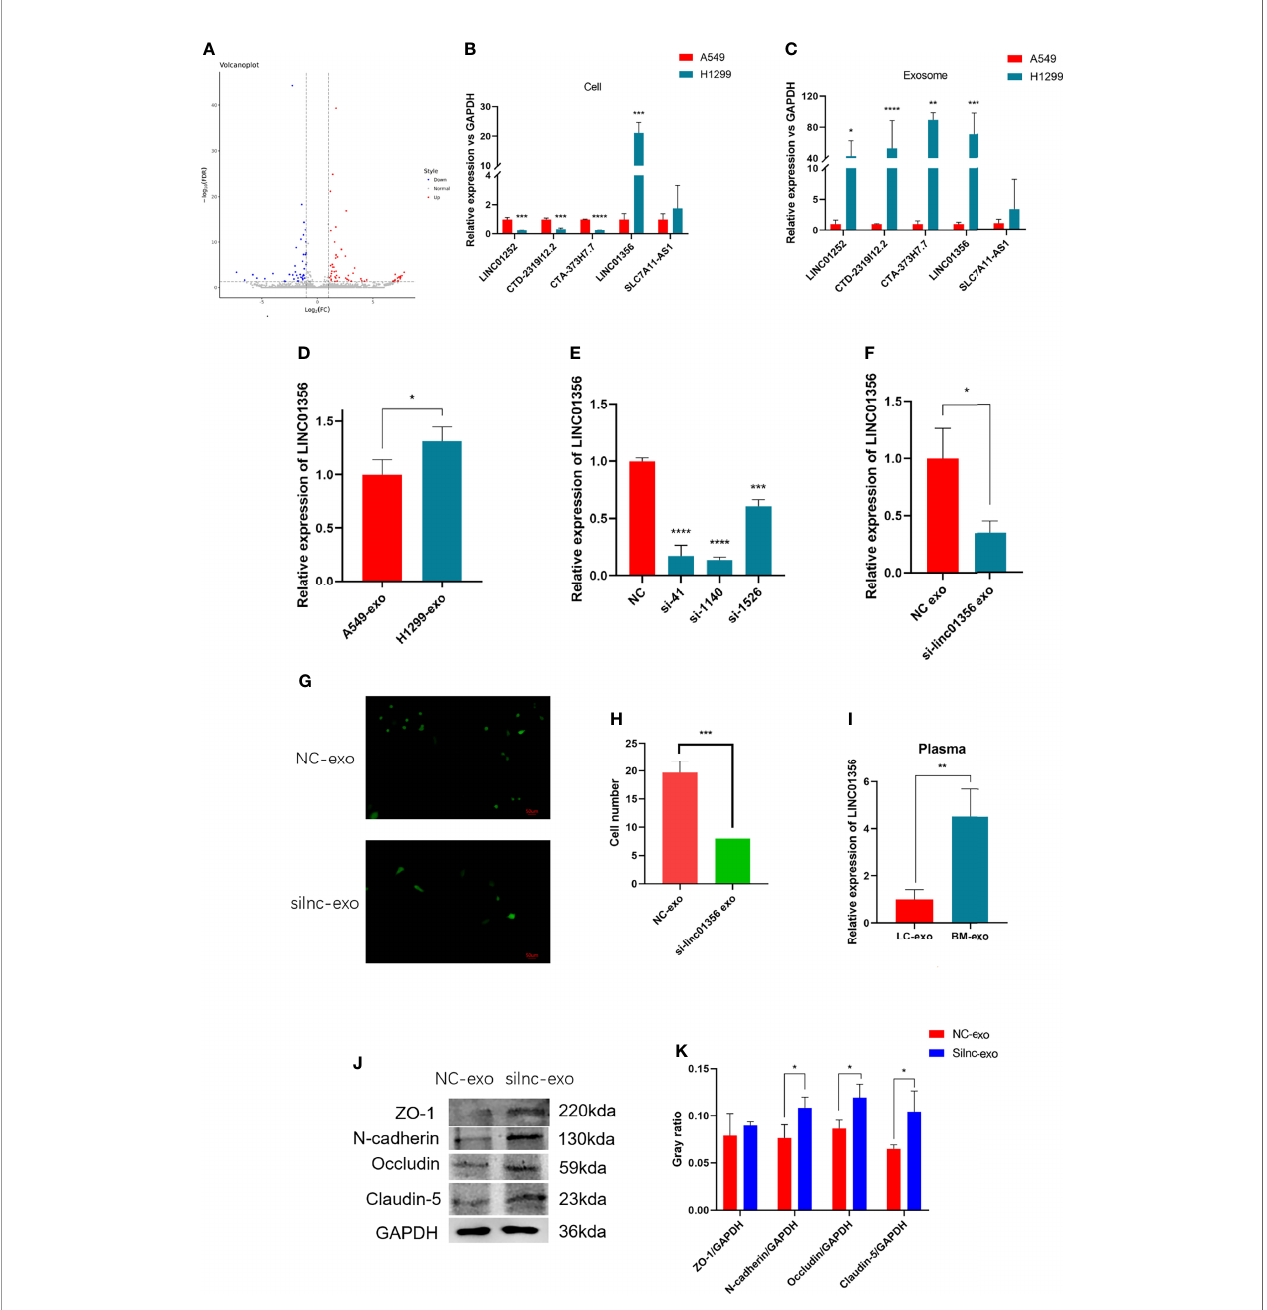
FIGURE 4 | Mechanism of exosomal LINC01356 in vitro BBB model remodeling and lung cancer brain metastasis. (A) Volcano plot of differentially expressed lncRNAs between brain metastatic and nonbrain metastatic lung cancer cells. Data were obtained from the GSE126548 database. (B) The top fi ve most highly differentially expressed lncRNAs were veri fi ed by RT – PCR in A549 and H1299 cells. (C) The top fi ve most highly differentially expressed lncRNAs were veri fi ed by RT – PCR in exosomes from A549 and H1299 cells. (D) LINC01356 expression level of BMECs incubated with exosomes from A549 and H1299 cells. (E) Different interference rates of siRNAs were veri fi ed by RT – PCR. (F) LINC01356 expression level of BMECs incubated with NC-Exos and silnc-Exos. (G) Immuno fl uorescence image and number of A549 cells crossing through the BBB in vitro model treated with NC-Exos and silnc-Exos. (H) Cell number of Fig. 3g. (I) Expression level of LINC01356 in LC-Exos and BM-Exos. (J) Western blotting was used to detect the expression of tight junction and adhesive proteins in BMECs treated with NC- Exos and silnc-Exos. (K) Gray ratio of western blot for junction protein. The expression levels of ZO-1, N-cadherin, Occludin and Claudin-5 protein increased when siRNA interfered with LINC01356. Among them, the expression of ZO-1 was not statistically signi fi cant. (NC-Exo= exosomes derived from H1299 cells without siRNA transfection, silnc-Exo= exosomes derived from H1299 cells treated with siRNA, LC-Exo= plasma exosomes from lung cancer patients without metastasis, BM-Exo= plasma exosomes from lung cancer patients with brain metastasis, *P < 0.05, **P < 0.01, ***P < 0.001, ****P < 0.0001).